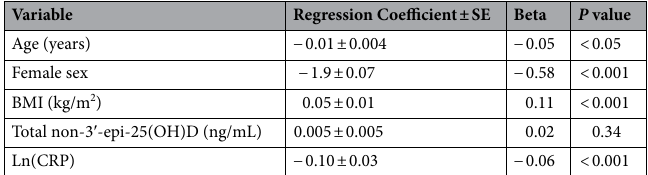
Table 7. Lack of association between total non-3 ′ -epi-25(OH)D and haemoglobin levels, independent of hsCRP and other